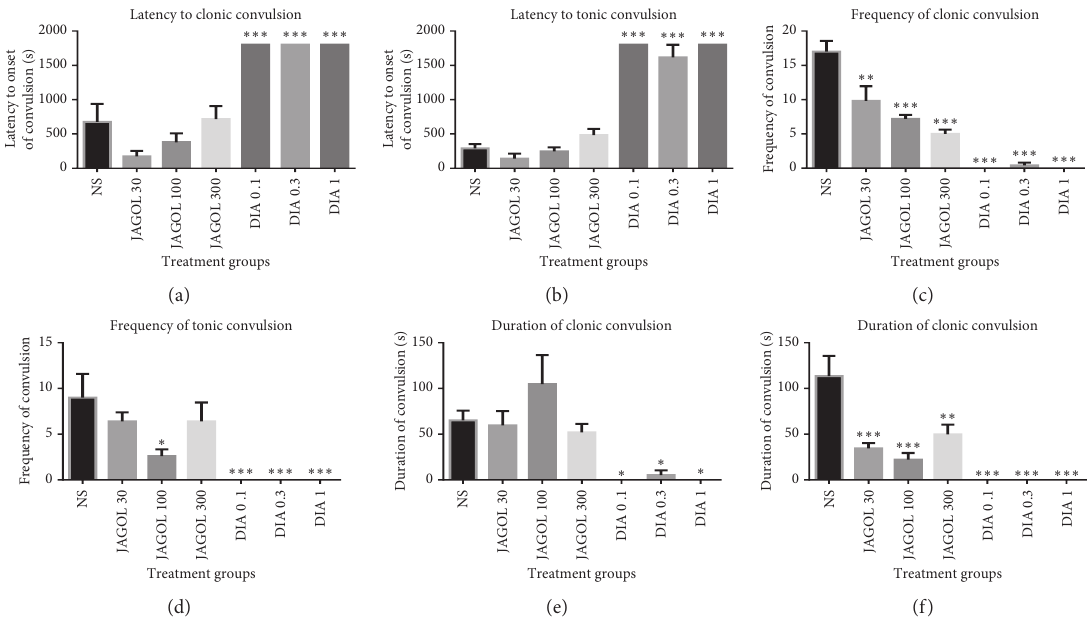
Figure 2: Effect of JAGOR (30–300 mg/kg, p.o .) and diazepam (0.1–1.0 mg/kg, i.p .) on the latency to PTX-induced (a) myoclonic and (b) tonic convulsions, frequency of (c) myoclonic and (d) tonic convulsions, and duration of (e) myoclonic and (f) tonic convulsions. Each column represents the mean ± SEM ( n � 5). ∗∗∗ P < 0 . 001, ∗∗ P < 0 . 01, and ∗ P < 0 . 05, one-way ANOVA followed by Bonferroni’s multiple comparison test. JAGOR: Jatropha gossypifolia root extract; DIA: